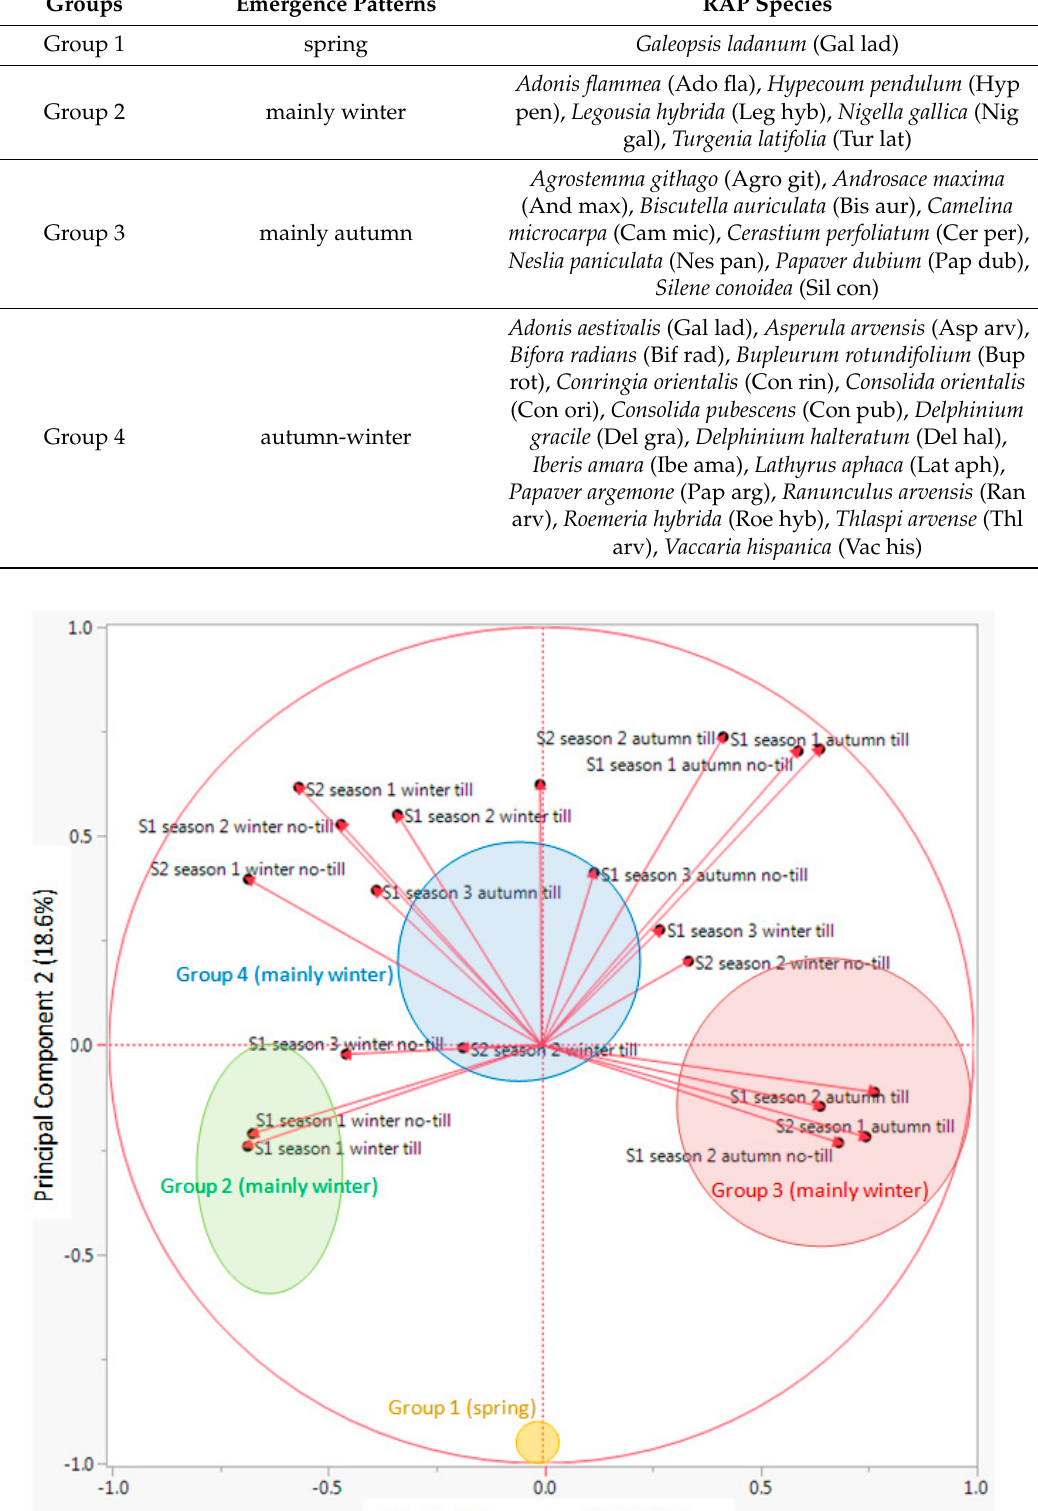
Table 2. Groups defined according to the K-means cluster analysis. Letters in parenthesis represent the code used for graphical representation of the K-means clustering on a PCA biplot (Figure 5).